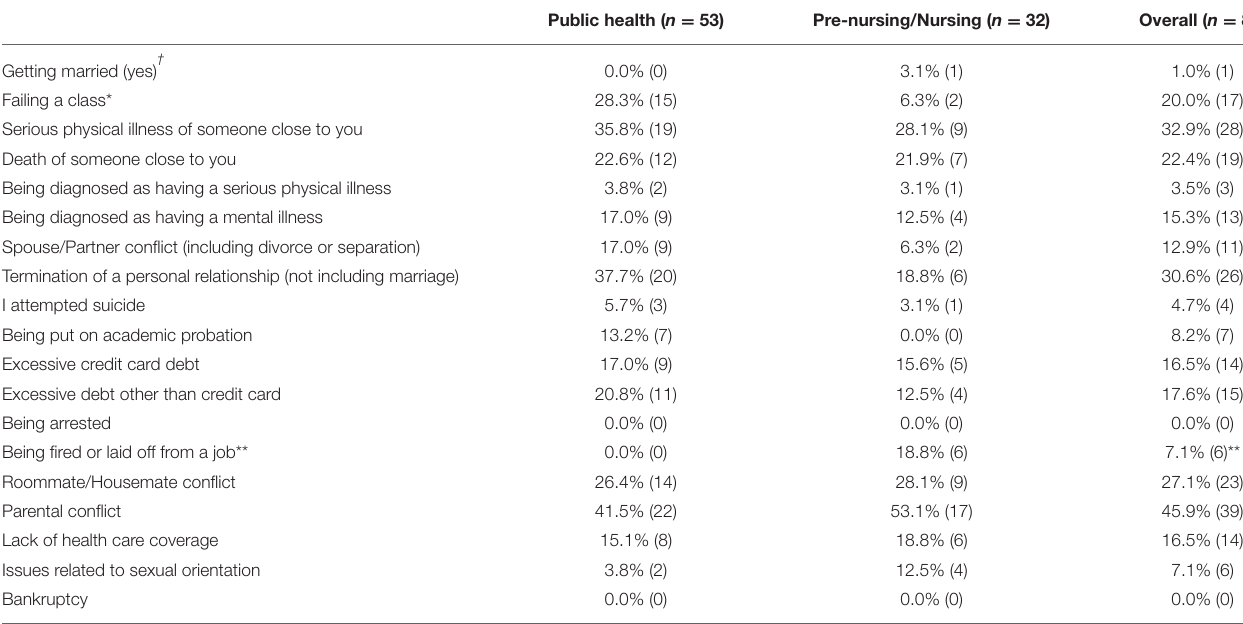
TABLE 4 | Stressor types by major.